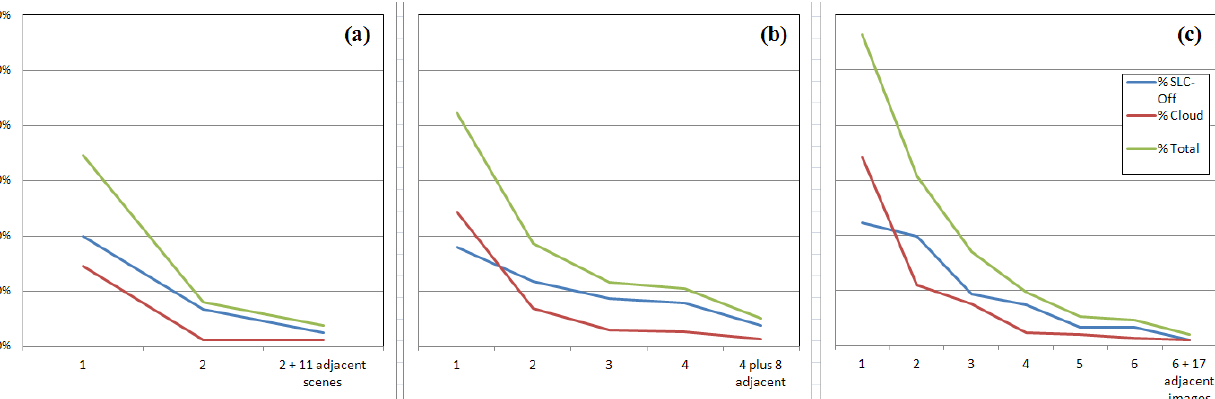
Figure 7. Graphical illustration of missing-data reduction per image when compositing images and adjacent scenes ( a ) two, ( b ) four and ( c ) six Landsat-7 SLC-Off images of the 2010 composite mosaic, plus images of adjacent scenes (corresponding spatial illustrations of these scenes are given in Figure 8 and in the appendix). Percentages reported are with respect to the study area, not the entire scene. The scene path/rows for panes (a), (b) and (c) are 126/060, 127/059, and 124/060,